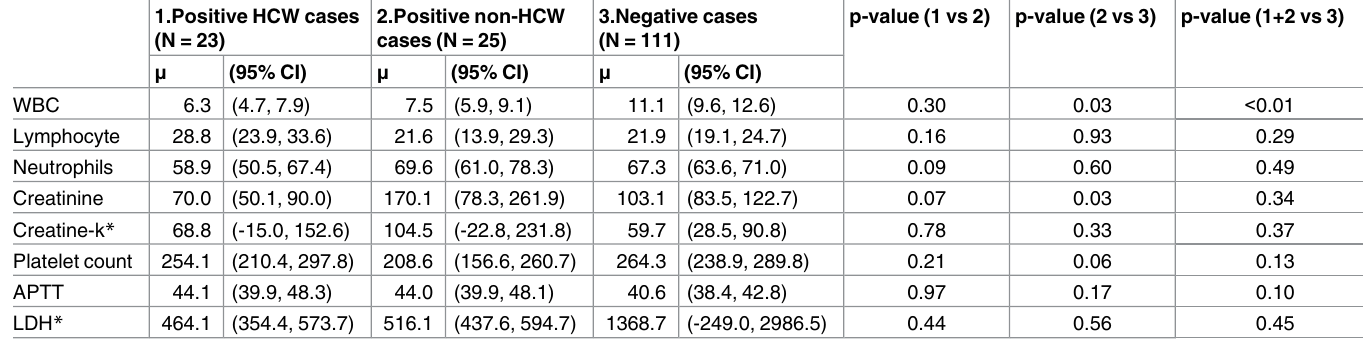
Table 4. Comparison of laboratory parameters among three patient groups.